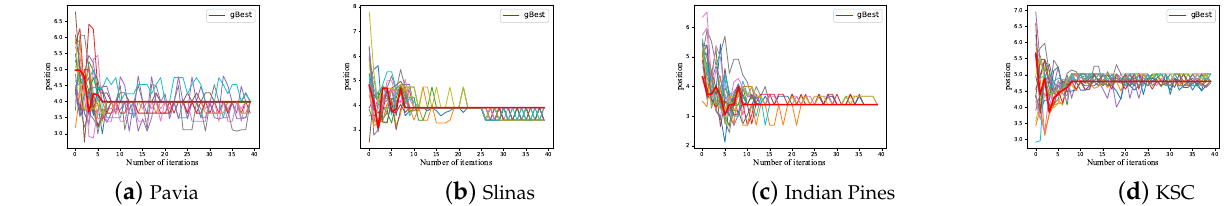
Figure 9. Positions of 20 particles and gBest during the iterations based on four biased HSI datasets by